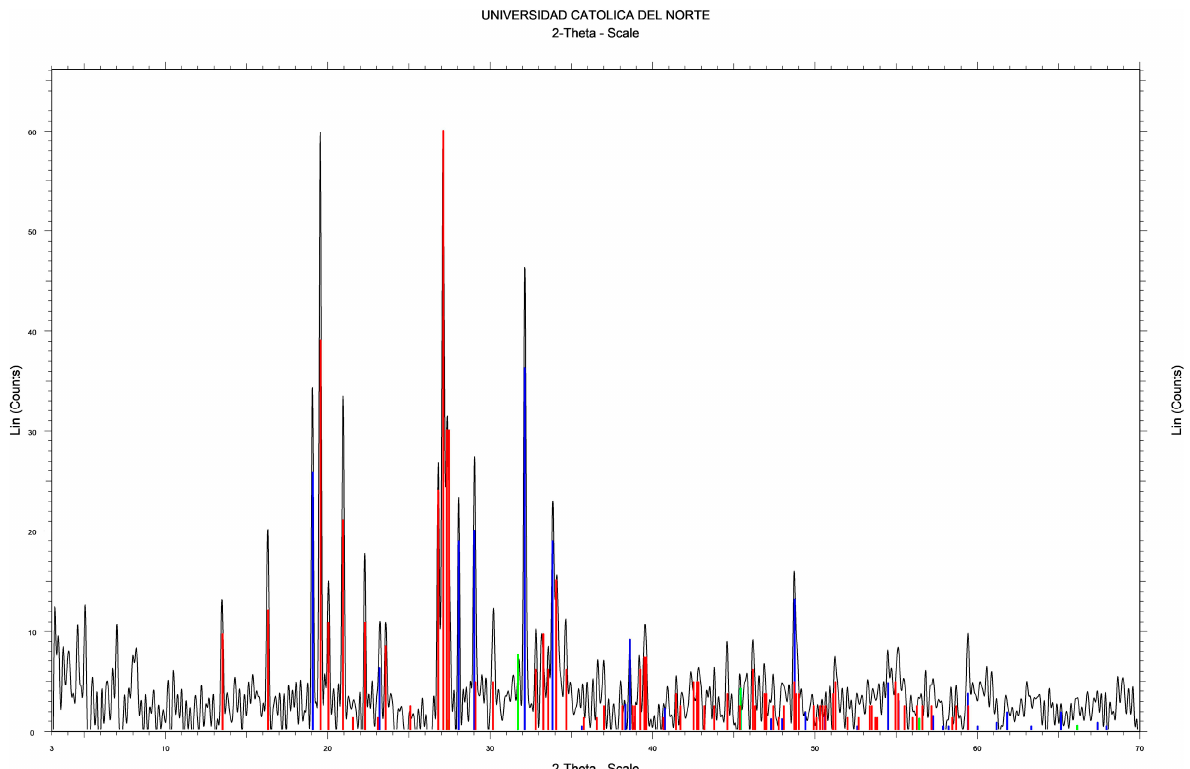
Figure 3. XRD patterns of the solids using Na 2 CO 3 .